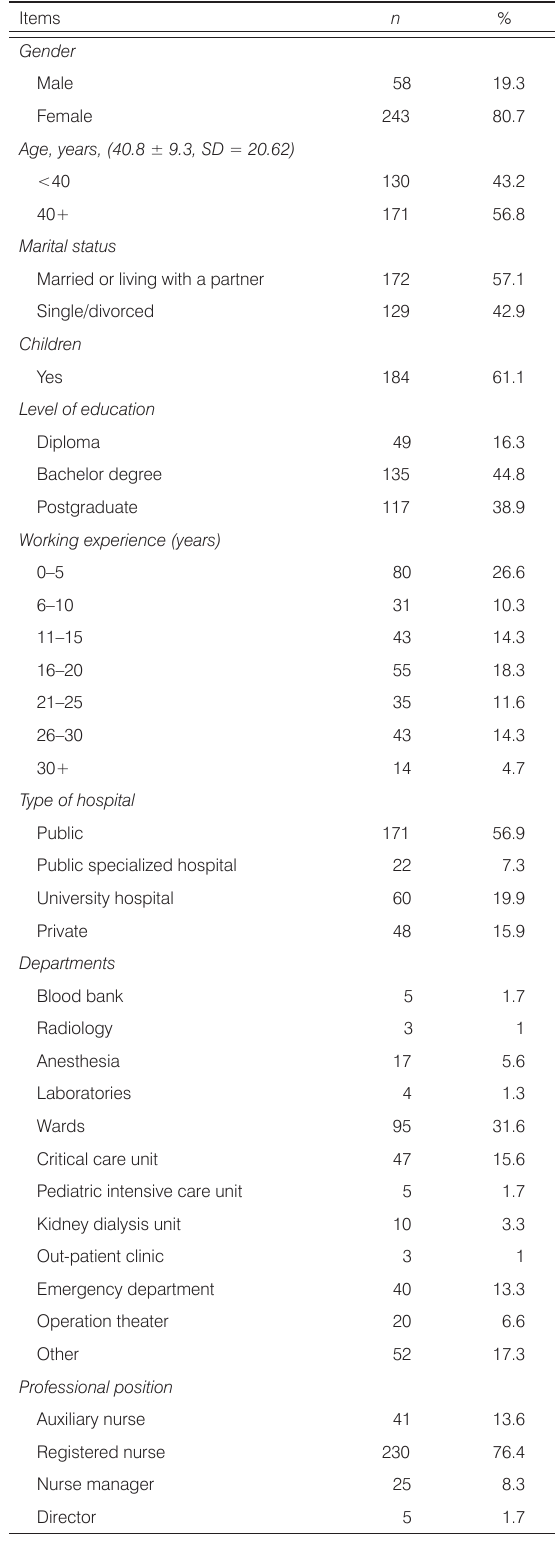
Table 1. Descriptive characteristics of the study